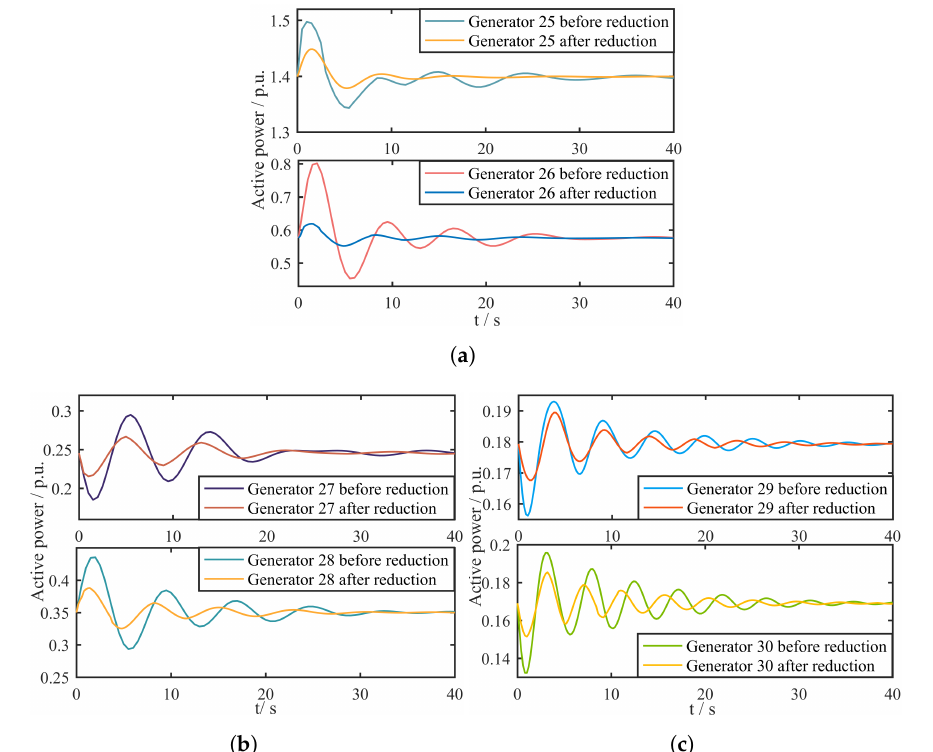
Figure 12. Output active power before and after simplification of the generator nodes